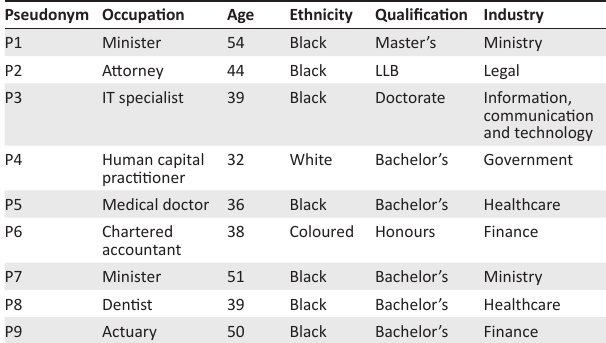
TABLE 1: Demographic characteristics of the